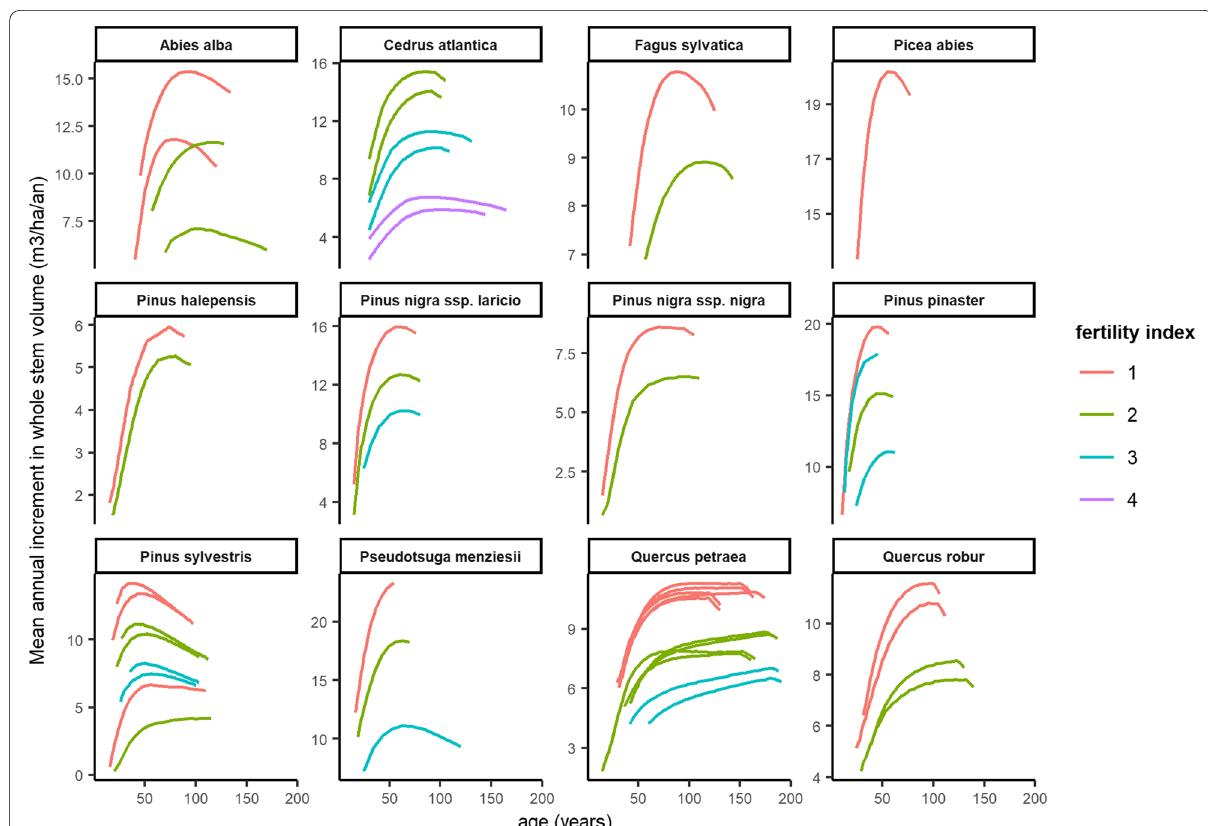
Fig. 2 Temporal evolution of simulated MAI in whole stem volume for each silvicultural scenario of the database. Silvicultural scenarios are discriminated by fertility index (specific for a species and silvicultural context, a same index does not correspond to equivalent environmental conditions for two different silvicultural guides), the different silvicultural guides and alternatives, or stand origins are not discriminated